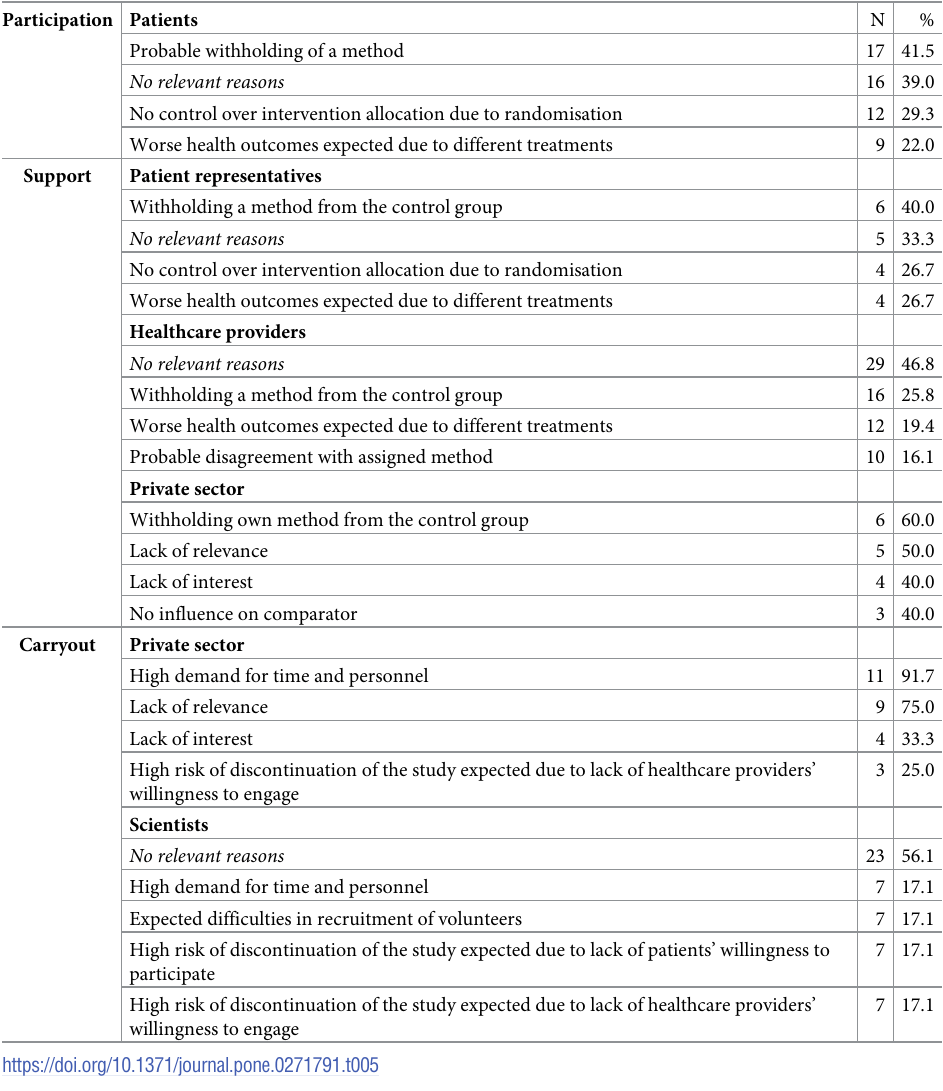
Table 5. Motives against engagement in randomised controlled